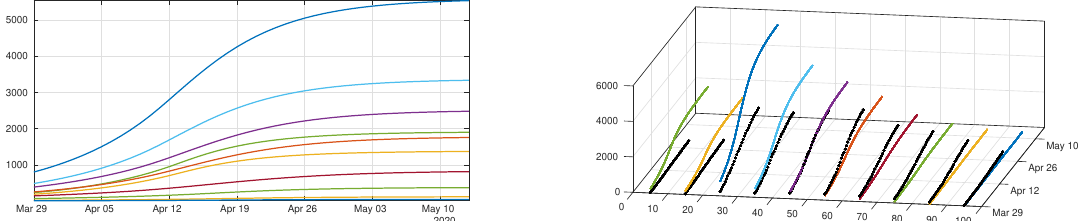
Figure 12. Cumulative number of unreported cases as given by the fit of the model (12)–(15) to Japanese data. The solid curves represent the solution of the model and the black dots correspond to the reported cases data. Parameters are the same as in Figure